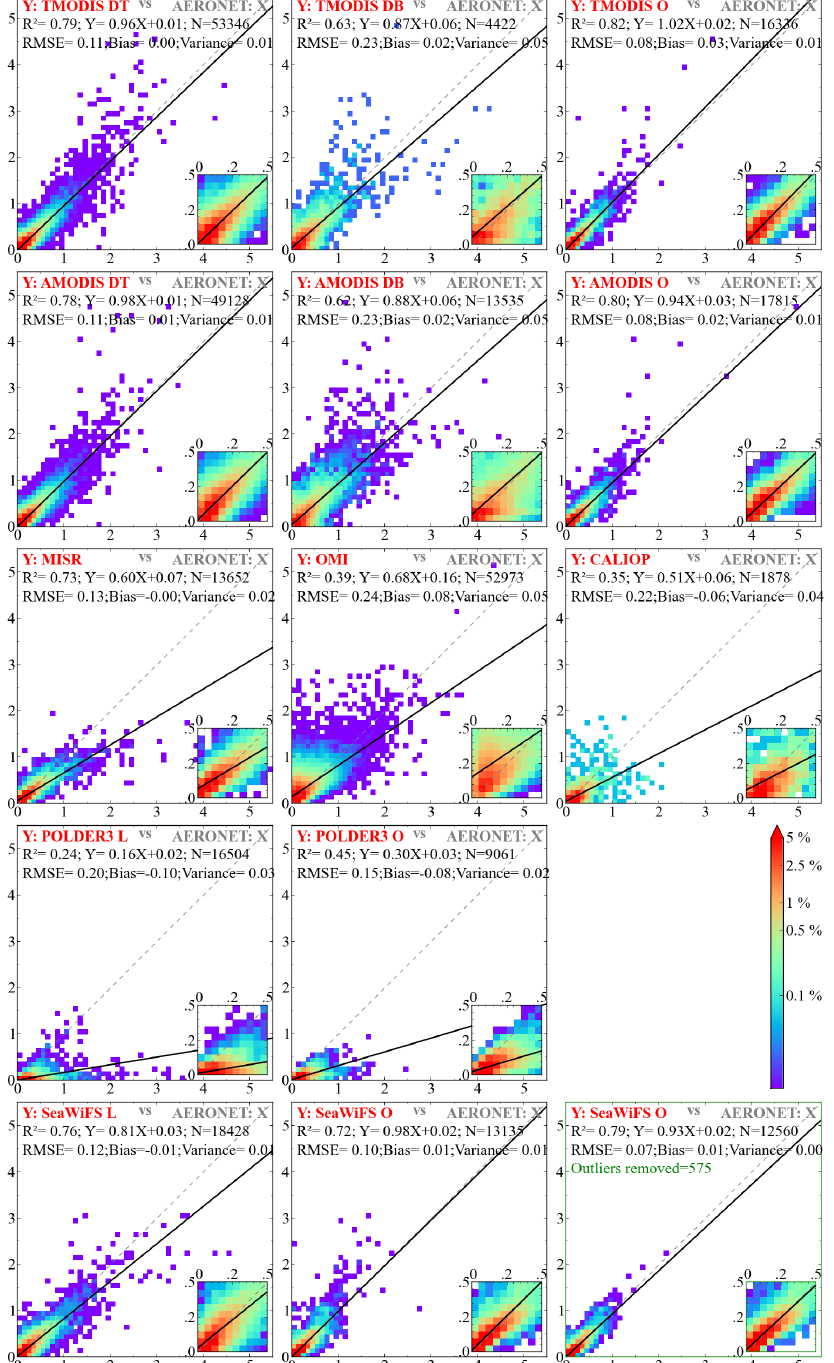
Fig. 6. Regression fits of AERONET AOD ( x axes) to AOD measured by spaceborne sensors ( y axes). Satellite data were pre-screened by QA as explained in Sect. 4. Density plots bin data into 0.1 AOD (0.05 AOD in magnified insets) intervals, where the color of each bin indicates the percentage of all data points that fall into this bin. Density plot in the bottom right corner (green frame) demonstrates the results of the possible data outlier detection and removal procedure described in Sect. 5, compared to the bottom middle plot. The insets (0–0.5 AOD range magnified) are intended to enhance the visualization of the linear regression fits near the origin.